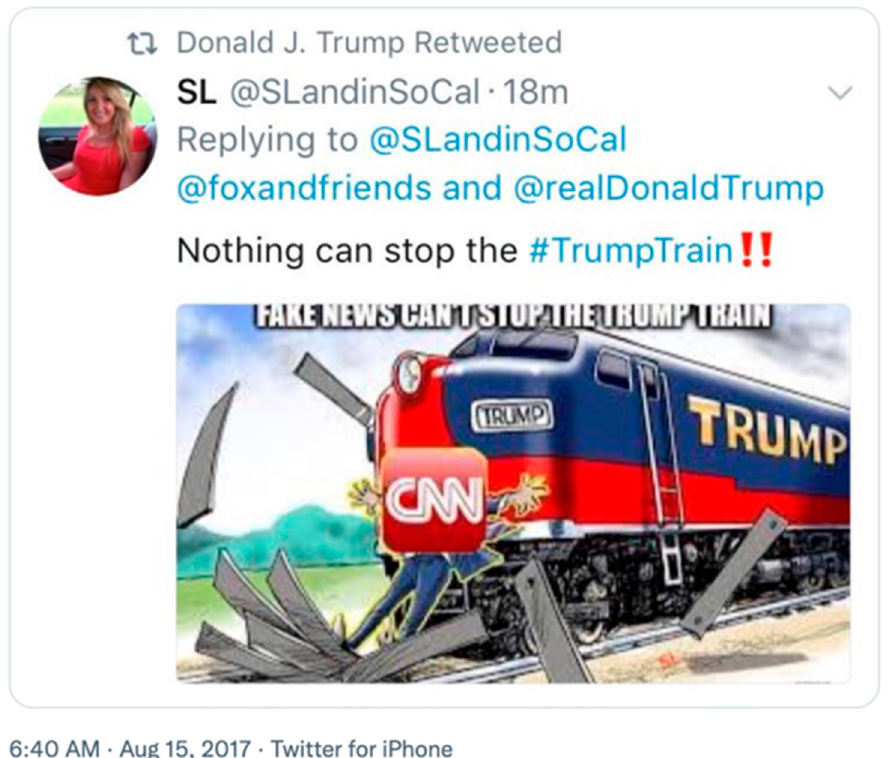
Figure 2. Tuesday morning Trump train retweet.